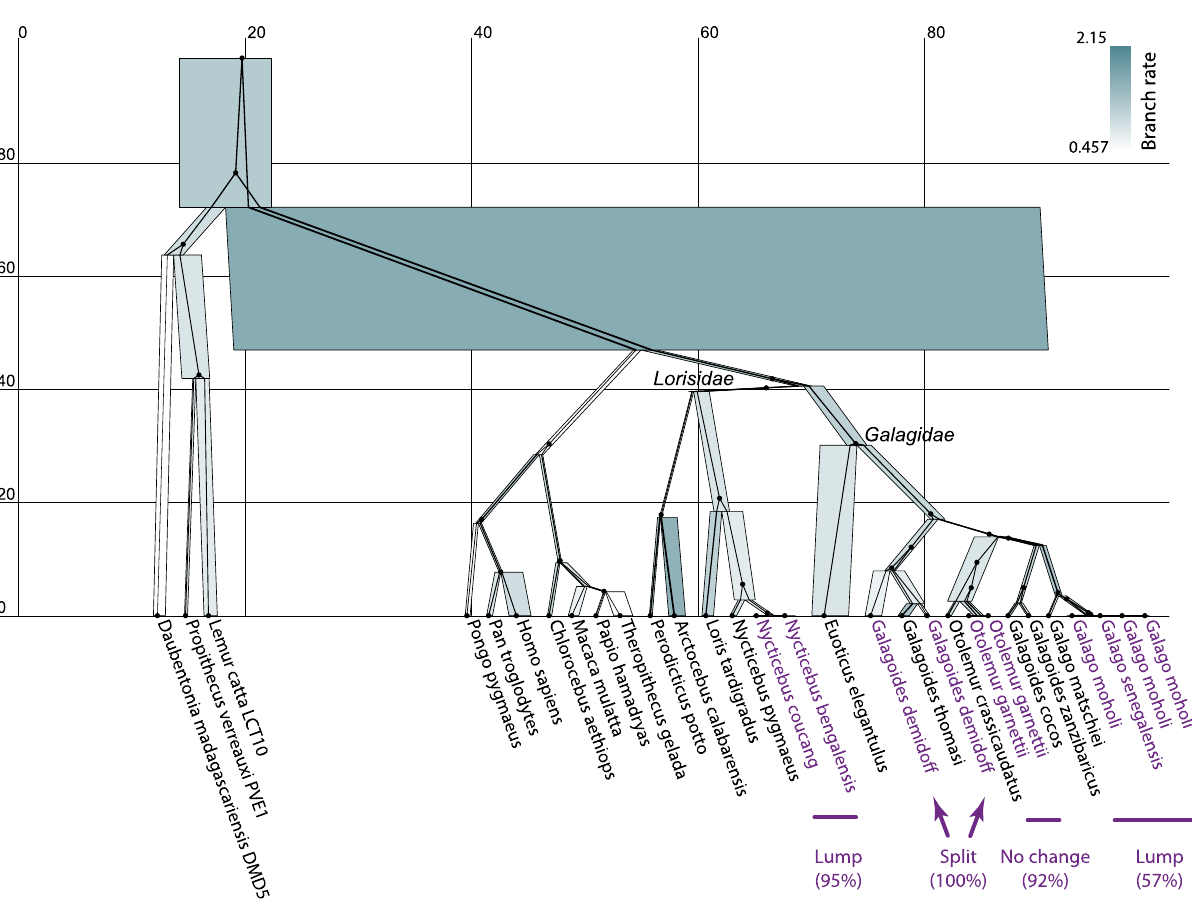
Fig. 4 Maximum a posteriori species tree of the gecko dataset 4 . The tree (left) was constructed from 129 genomic loci (right), for ϵ = 10 − 2 substitutions per site. Branches are coloured by effective population size θ . Only segregating sites (i.e., SNPs which vary among samples) are displayed, and sites are coloured by minor allele (A/C: homozygous; B: heterozygous). The misclassi fi ed gecko is indicated by a red asterisk *. The analysis was performed using SNAPPER 28 and the fi gure was generated using PEACH Tree 48 .